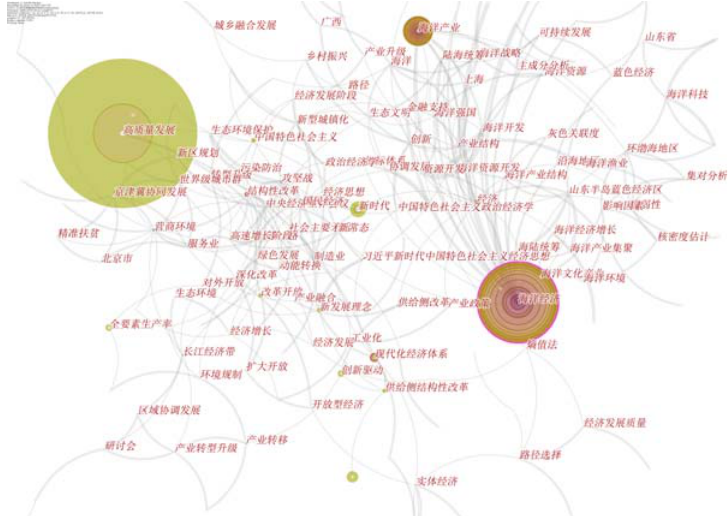
Figure 1. The keywords of marine economy literature